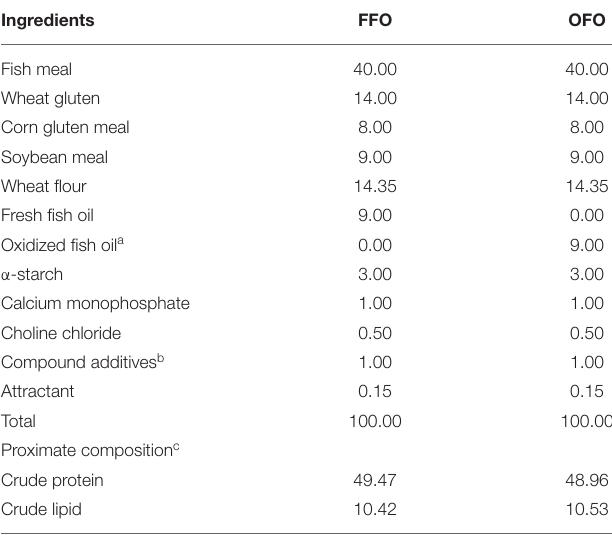
TABLE 1 | Composition and nutrients levels of the test diets (air dry matter